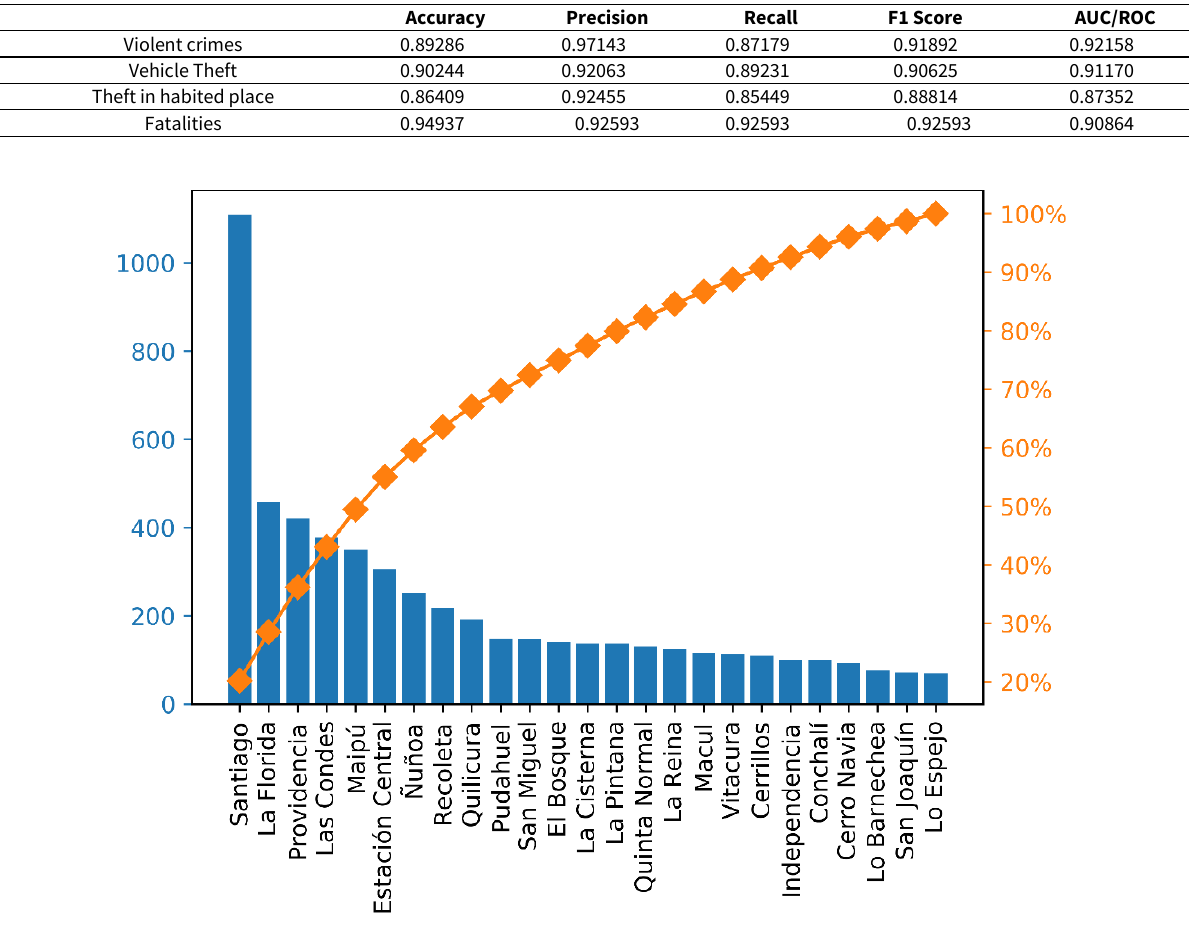
Figure 5. News distribution by commune of the metropolitan region,